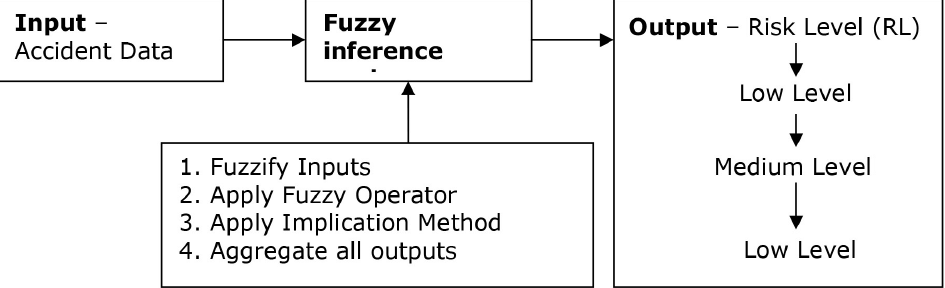
Figure 3. Fuzzy Inference